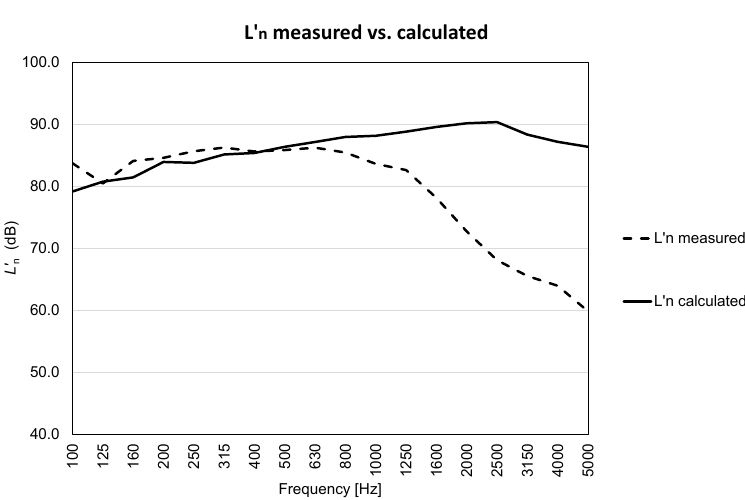
Figure 9. Measured vs. predicted impact noise.